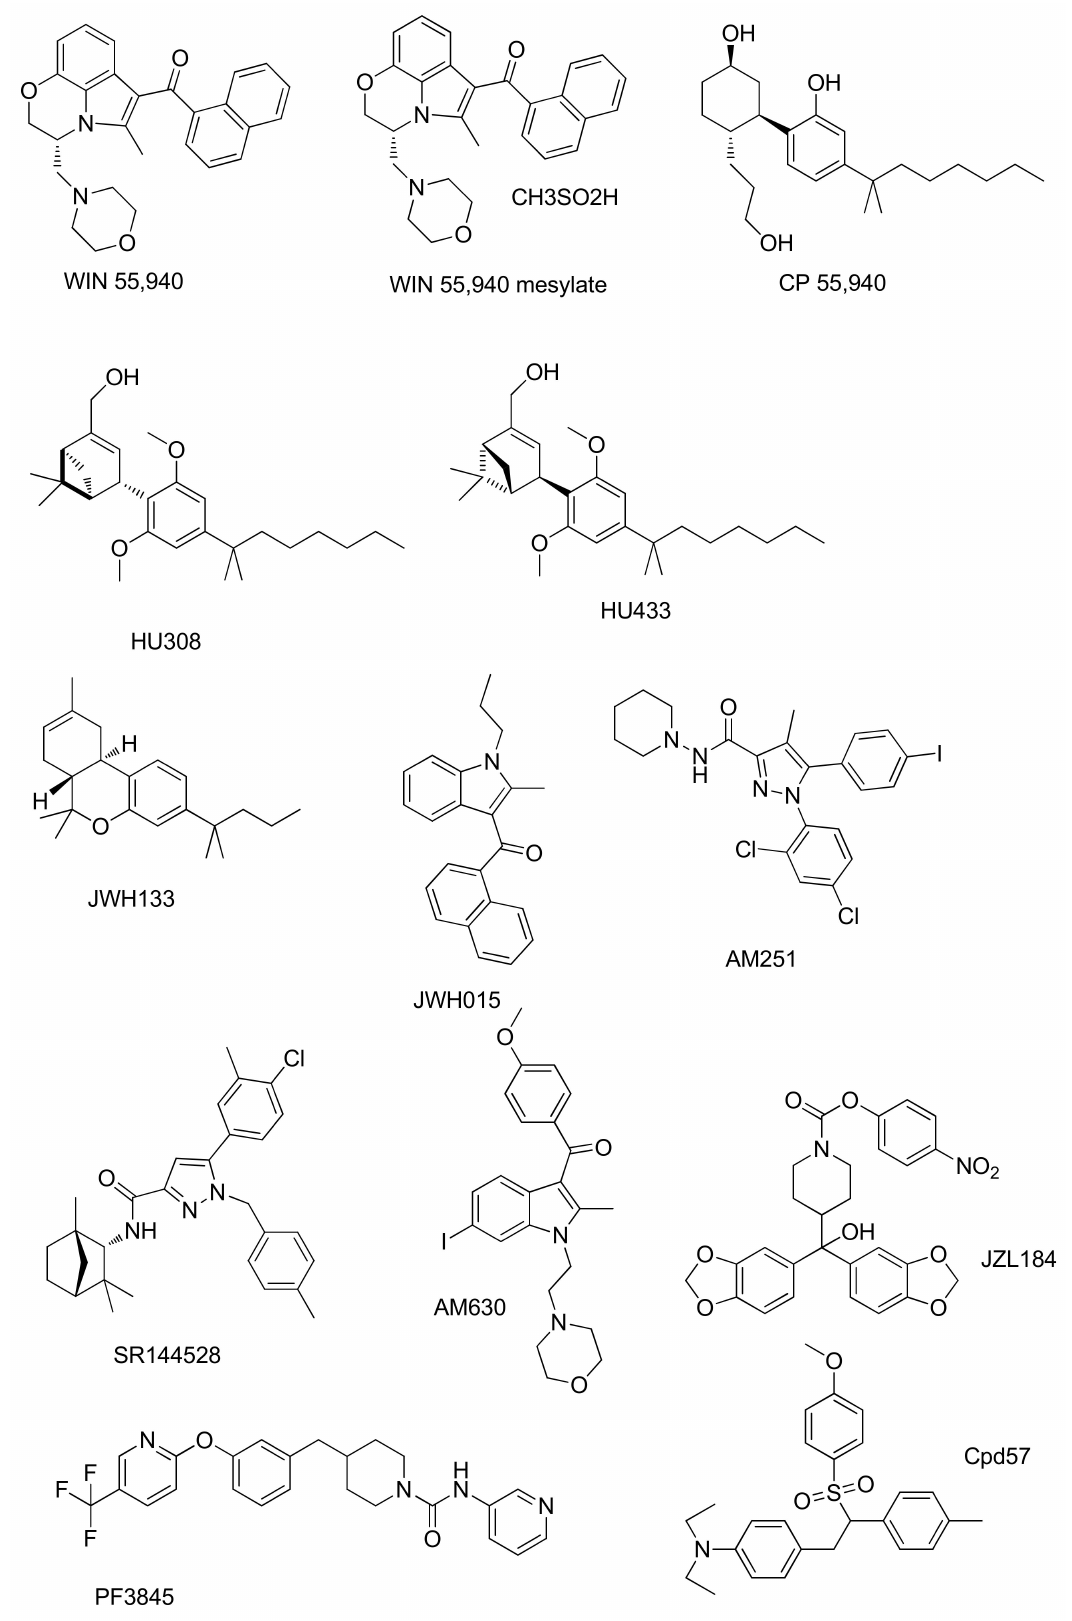
Figure 4. Structures of ECS synthetic modulators studied in bone